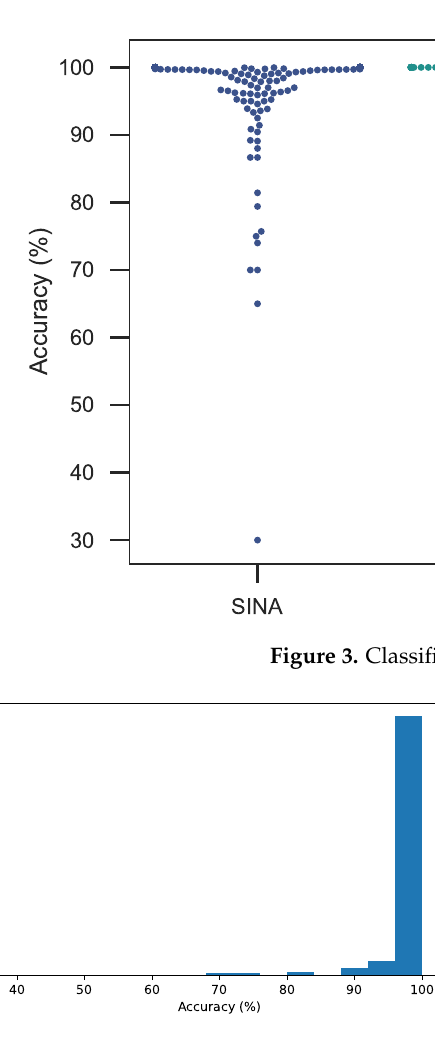
Figure 4. Confusion matrix